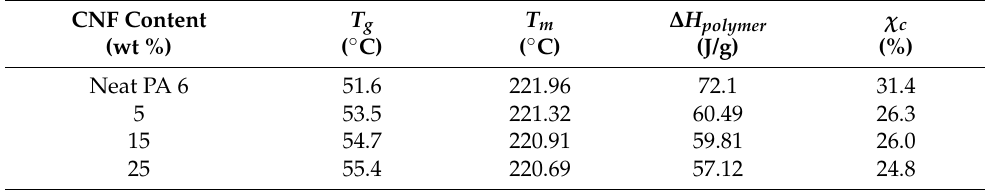
Table 3. Thermal properties of neat PA 6 and PA 6/CNF